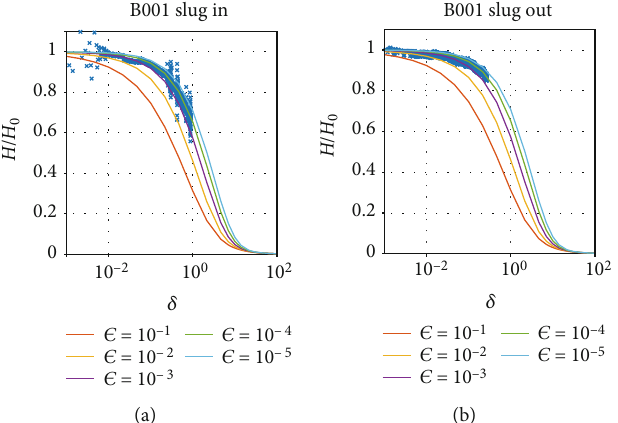
Figure 8: Slug test analyses for borehole B001. α is a function of time, permeability, and radius of the casing. For (a), a slug of water was instantaneously injected into the borehole, and for (b), a slug of water was instantaneously removed from the borehole. If data collection were continued, normalized head values would follow selected curves of ϵ